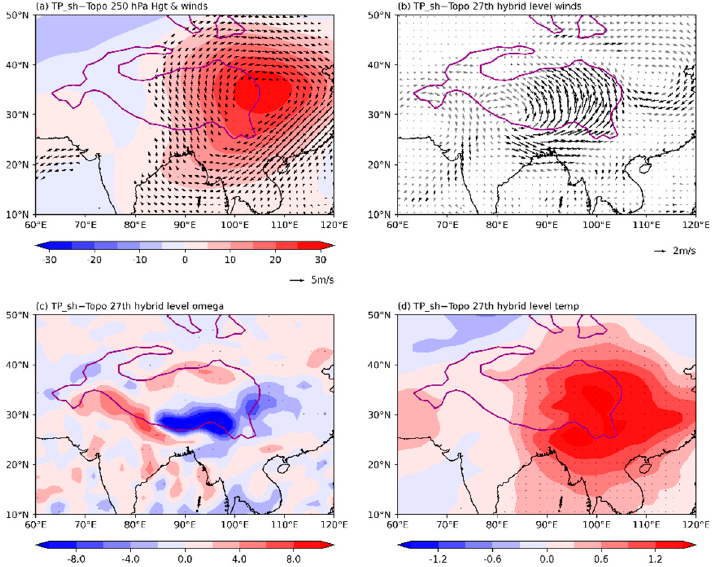
Figure 6. The differences in ( a ) zonal deviation of the 250 hPa geopotential height (shaded, unit: gpm) and winds (vector, unit: m/s), ( b ) 27th hybrid level winds (vector, unit: m/s), ( c ) 27th hybrid level temperature (shaded, unit: K), and ( d ) 27th hybrid level vertical velocity (shaded, unit: 0.01 Pa/s) between the TP_sh and Topo tests. Dots denote values and black vectors exceeding the 95% confidence level of Student’s t test. The purple line is the 2000 m elevation contour.